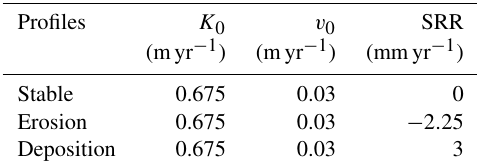
Table 3. Calibrated optimal parameter values for the Belgian study site. K d and v d were set to be 0.01m − 1 in the model calibration. The parameter values for SOC cycling are listed in Table 1. SRR indicates the soil redistribution rate.